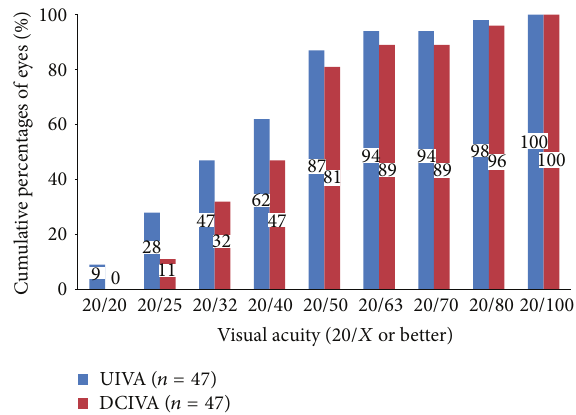
Figure 3: Monocular uncorrected intermediate visual acuity (UIVA) and distance-corrected intermediate VA (DCIVA) at 67cm at 6 months.